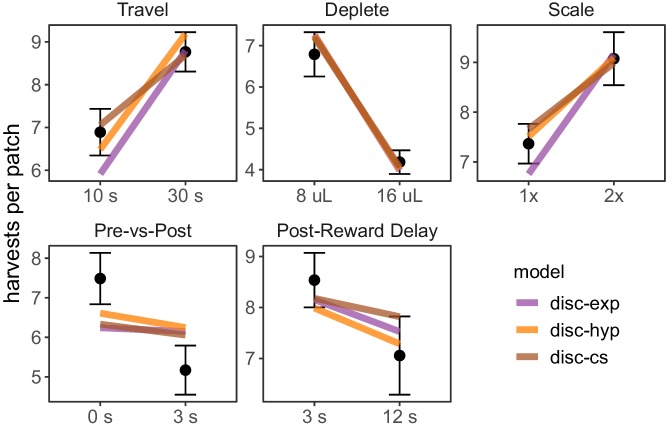
Predictions of the best fit discounting models.Predictions of the best fit exponential discounting model (disc-exp), hyperbolic discounting model (disc-hyp), and constant sensitivity discounting model (disc-cs). Points and error bars are the mean ± standard deviation of rat behavior; colored lines represent the mean predicted number of harvests across all rats.